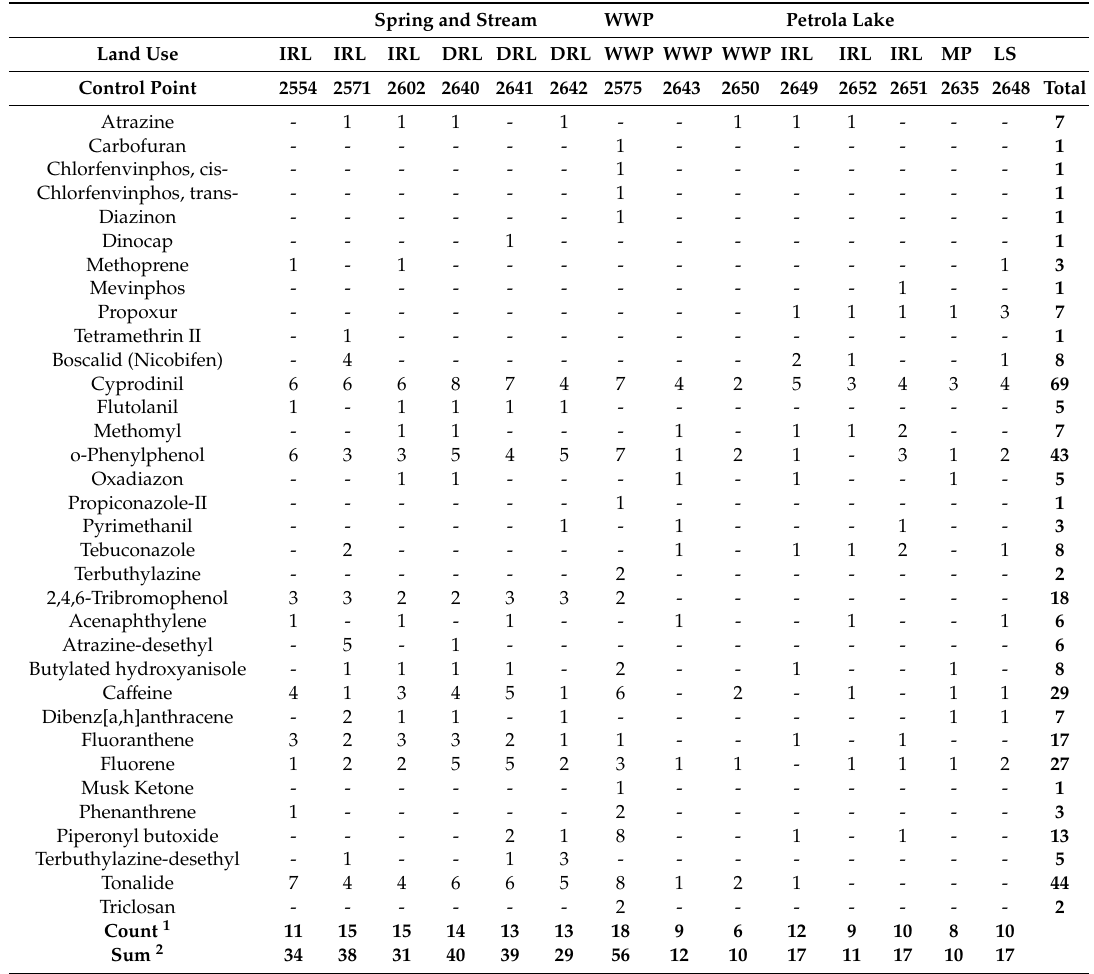
Table 1. Endocrine disrupting chemicals identified in water samples collected from small streams and springs surrounding the lake and lake surface water. Concentrations are given in ng / L. The main land use is indicated at each point: IRL: irrigated land; DRL: dry land; WWP: wastewater pond; MP: mining pond; LS: livestock. -: